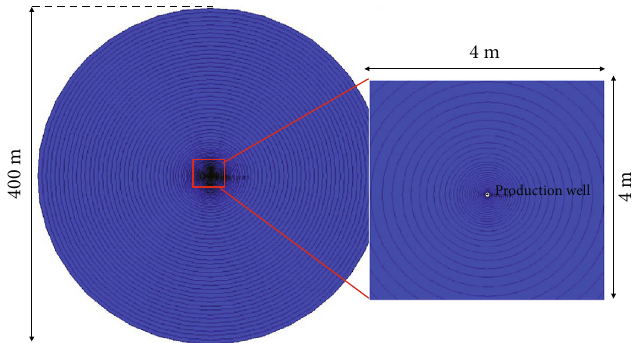
Figure 8: Mesh generation and local grid re fi nement.